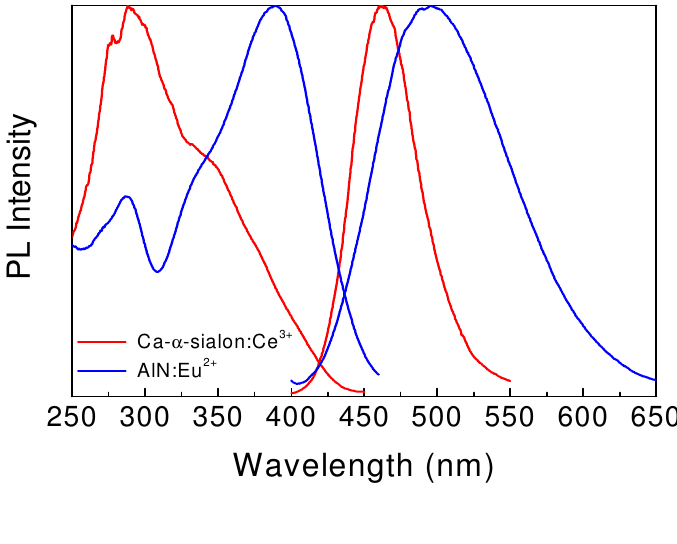
Figure 2. Excitation and emission spectra of blue-emitting Ca- α -sialon:Ce 3+ and AlN:Eu 2+